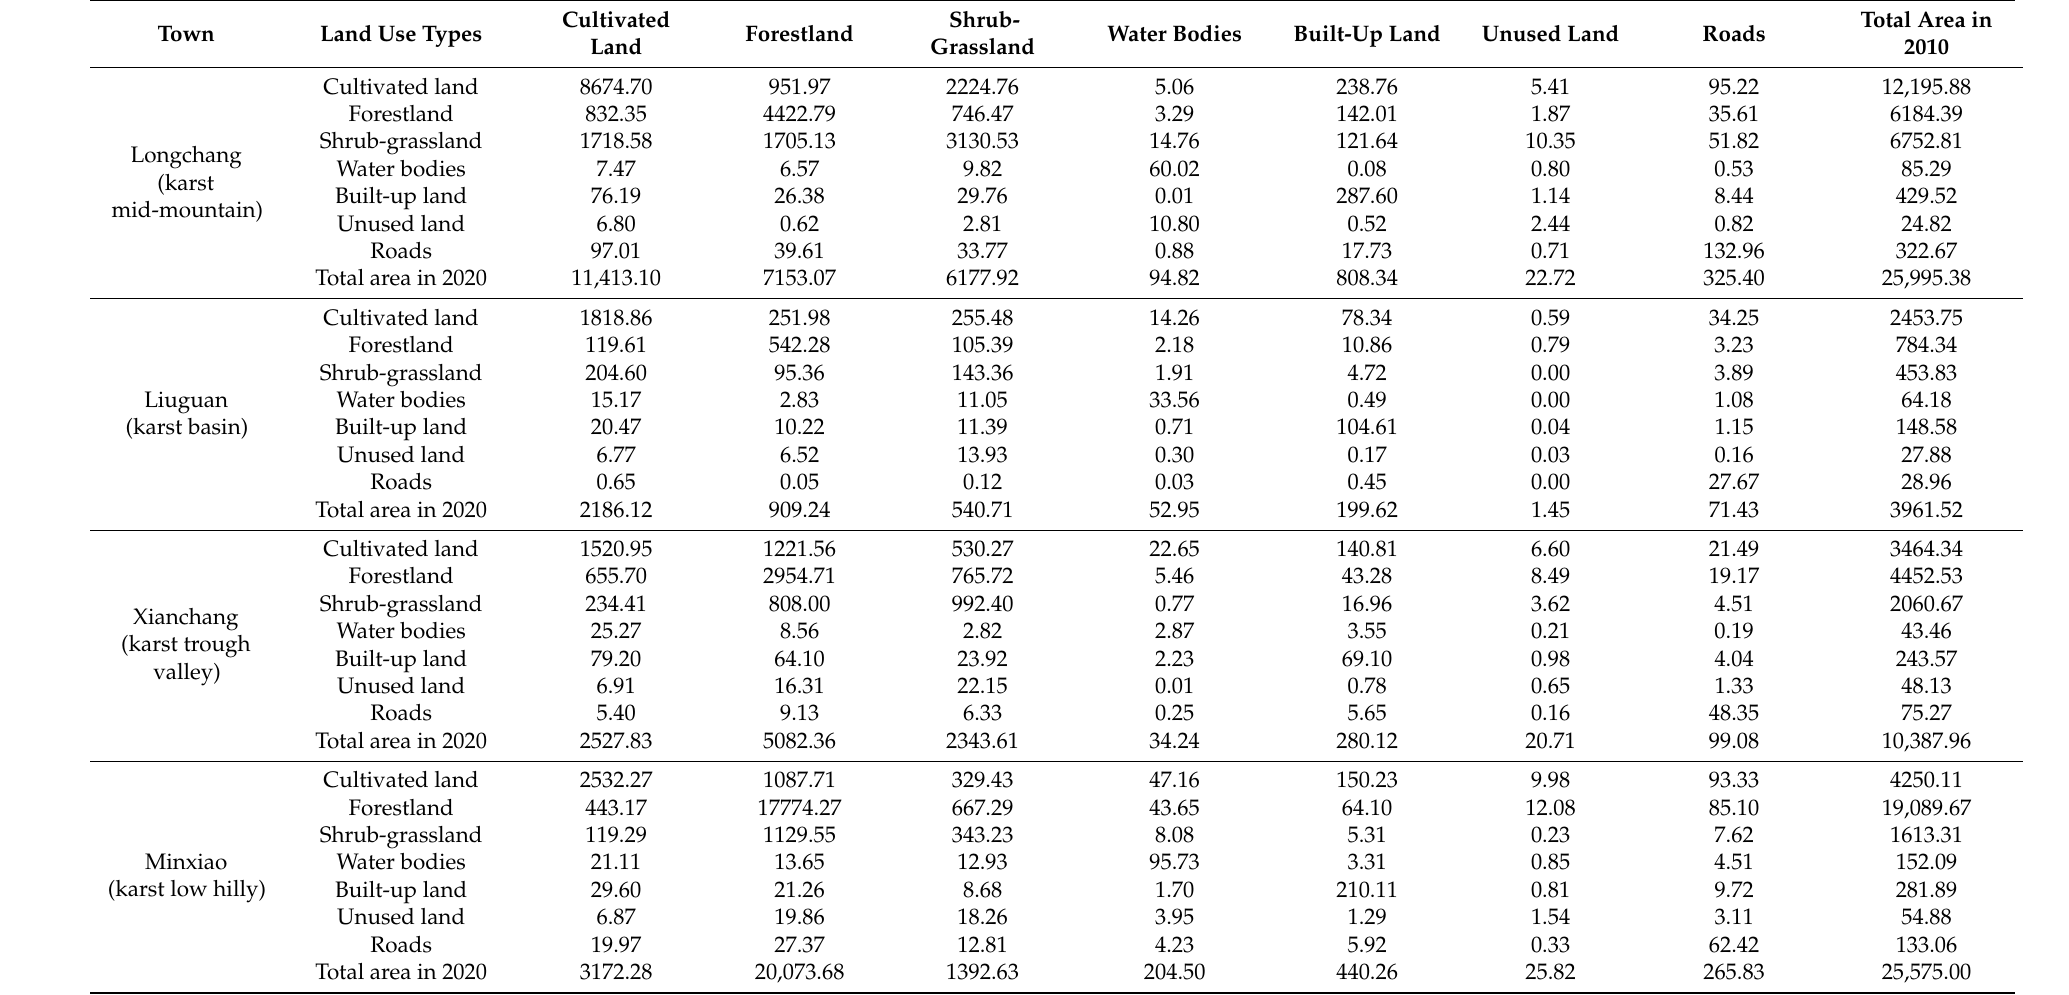
Table 2. The land-use change matrix from 2010 to 2020 (hm 2